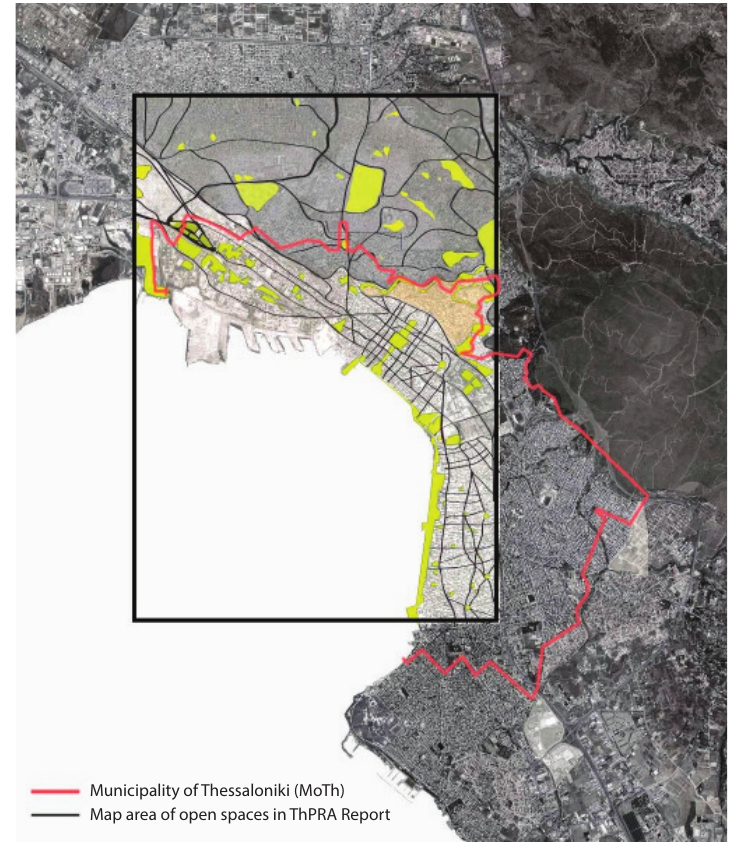
Figure 5. Open spaces in Thessaloniki as presented in the ThPRA policy document, compared with the official boundaries of MoTh. Source: Edited by the author based on MoTh and Resilient Thessaloniki